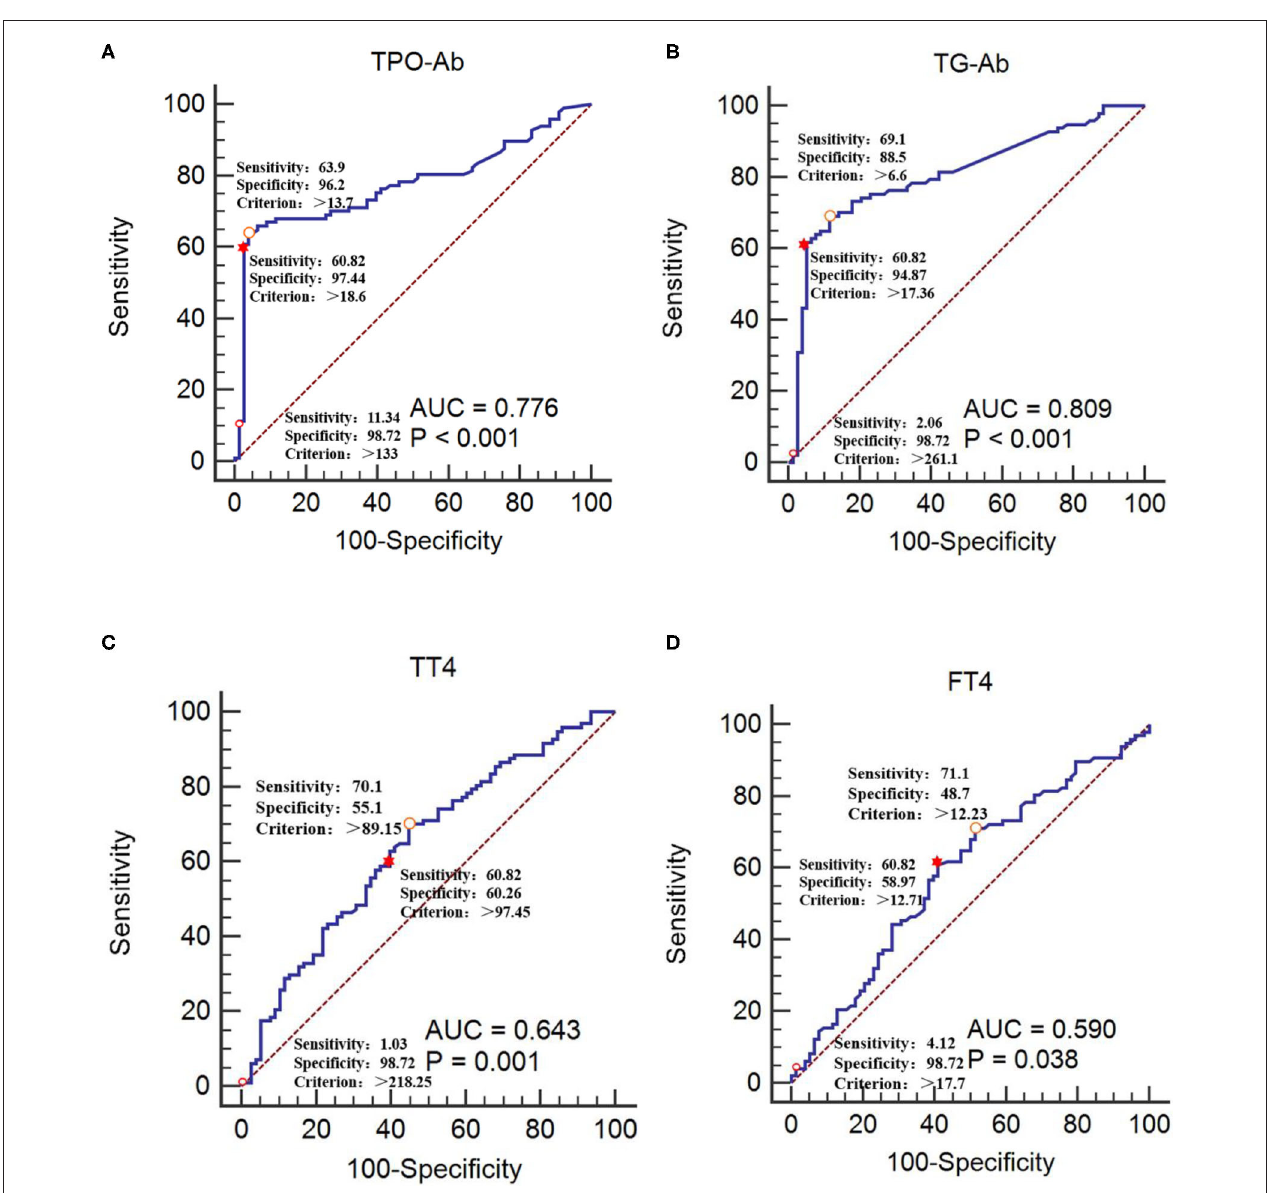
FIGURE 3 | Receiver operating characteristic curves of TPO-Ab, TG-Ab, TT4, and FT4 for GBS occurrence (A) TPO-Ab, (B) TG-Ab, (C) TT4, and (D) FT4. The CIDP group was used as the reference group, and the GBS group was used as the measurement group. The diagnostic cut-off value corresponds to the maximum point of the Youden index. The diagnostic cut-off value corresponds to the maximal specificity. The diagnostic cut-off value corresponds to sensitivity near to 60%.